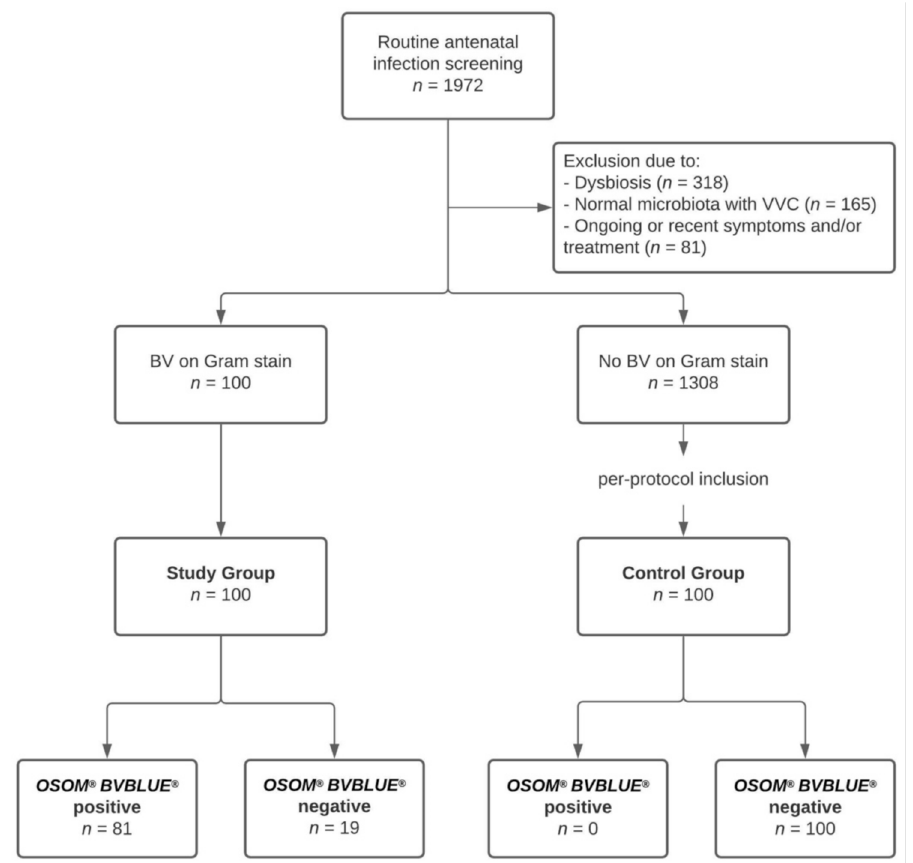
Figure 1. Inclusion criteria of 200 asymptomatic pregnant women, screened for BV using Gram- stained smears and the OSOM ® BVBLUE ® Test between 13 February 2020 and 18 March 2021. BV, bacterial vaginosis. VVC, vulvovaginal